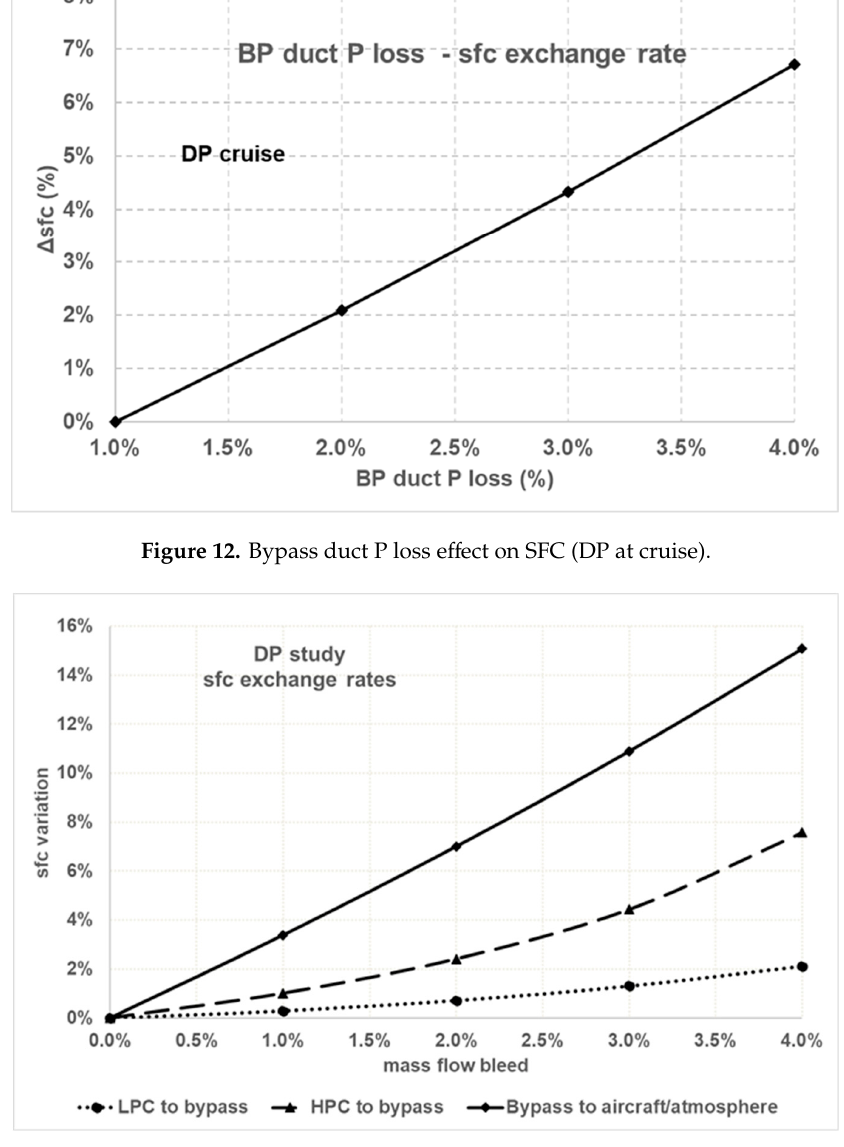
Figure 12. Bypass duct P loss effect on SFC (DP at cruise).